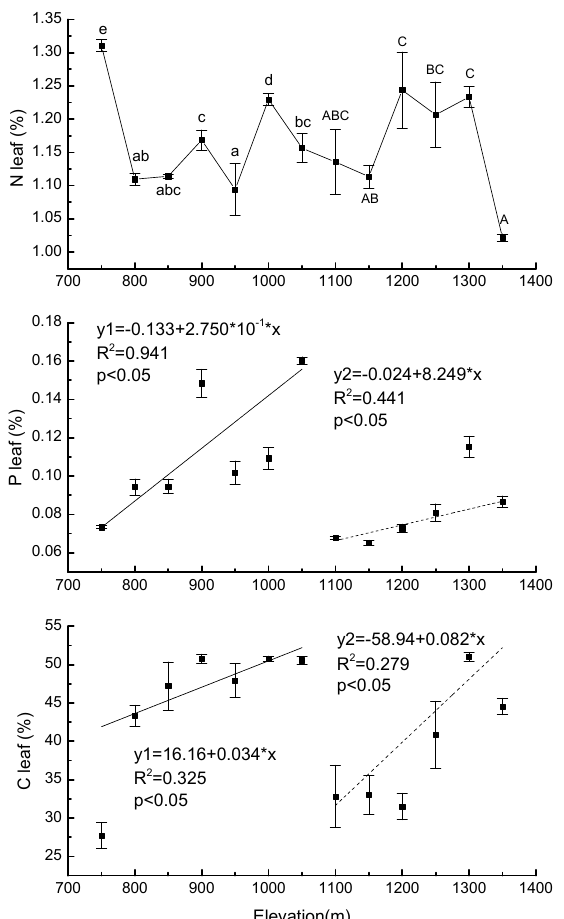
Figure 5. Regression equations of the mean values of total leaf N, total leaf P, and total leaf C content in Pinus koraiensis as a function of elevation on Changbai Mountain. The sample size was 7 for Pinus koraiensis and mixed broadleaved forests (solid lines) and 6 for evergreen coniferous forests (dotted lines). For each elevation, the sample size was 5. Lowercase letters denote significant differences among elevations in PBMF ( Pinus koraiensis and mixed broadleaved forests). Uppercase letters denote significant differences in ECF (evergreen coniferous forests) (both at the p < 0.05 level).